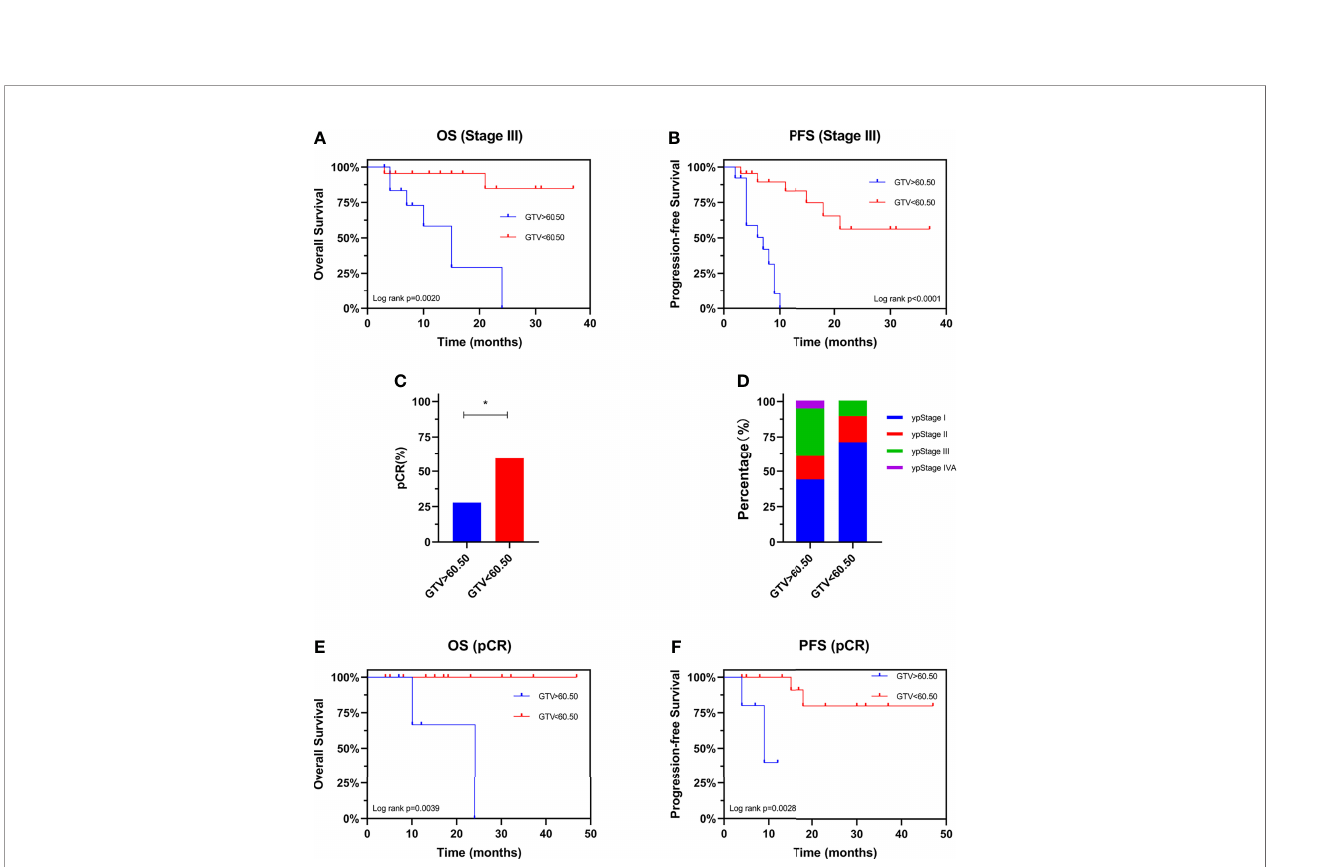
FIGURE 4 | Prognostic value of GTV. Kaplan-Meier curves are shown for overall survival (A) and progression-free survival (B) strati fi ed by GTV in patients with stage III disease. Pathological complete response rate (C) and ypStage (D) after neoadjuvant therapy strati fi ed by GTV. Kaplan-Meier curves are shown for overall survival (E) and progression-free survival (F) strati fi ed by GTV in patients achieving pCR. *P < 0.05 by c 2 test. GTV, gross tumor volume; pCR, pathological complete response; ypStage, post-neoadjuvant pathological